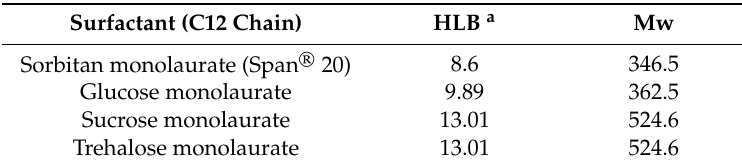
Table 1. Selected surfactant for niosomes